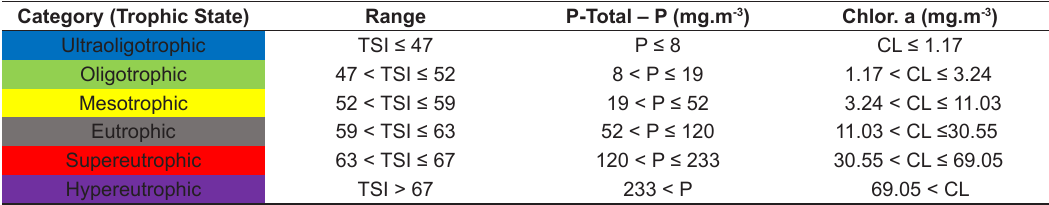
Table 1. Trophic state classification for reservoirs (modified by Pompêo, 2017). Category (Trophic